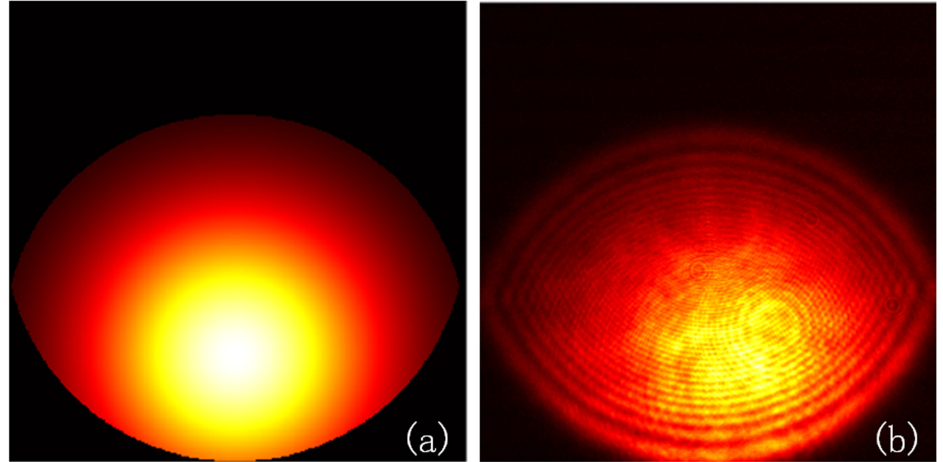
Figure 9. Spot image on the camera when the tilt angle is (6 ◦ , 90 ◦ ). ( a ) Simulated spot image. ( b ) Experimental spot image.